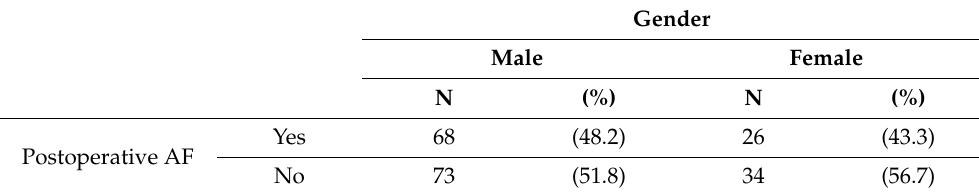
Table 4. Prevalence of postoperative AF by gender of participants.